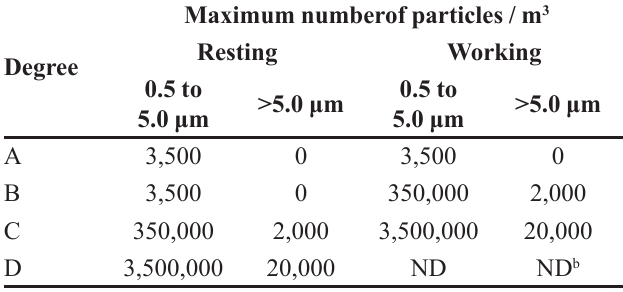
TABLE II - Classification for sterile products manufacturing